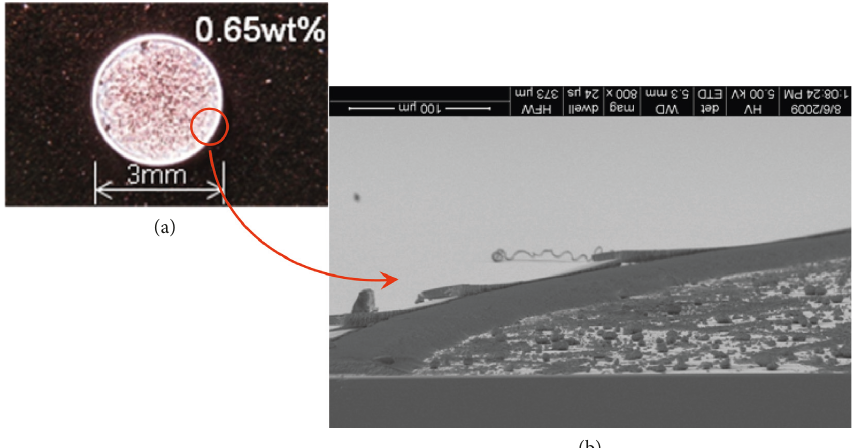
Figure 12: Deposition pattern of silica particles in the water sessile drop on a glass